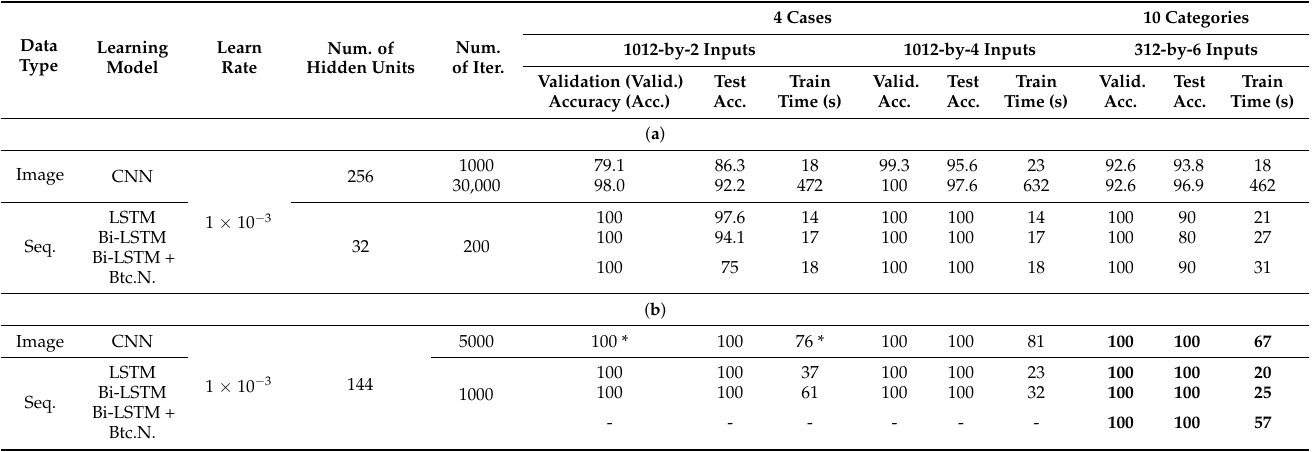
Table 8. Results of deep learning models. (a) Initial results. (b) Performance of the neural networks after error regularization and data